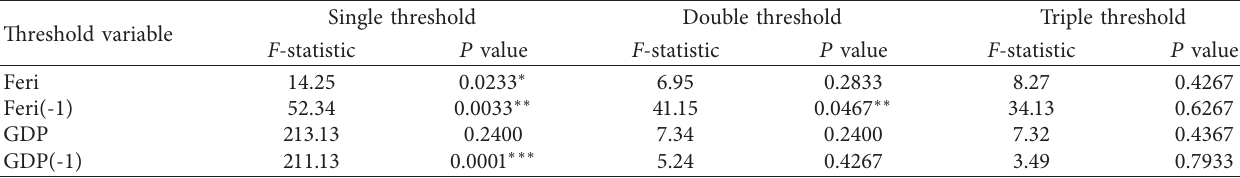
Table 7: Threshold variable selection and self-sampling test.